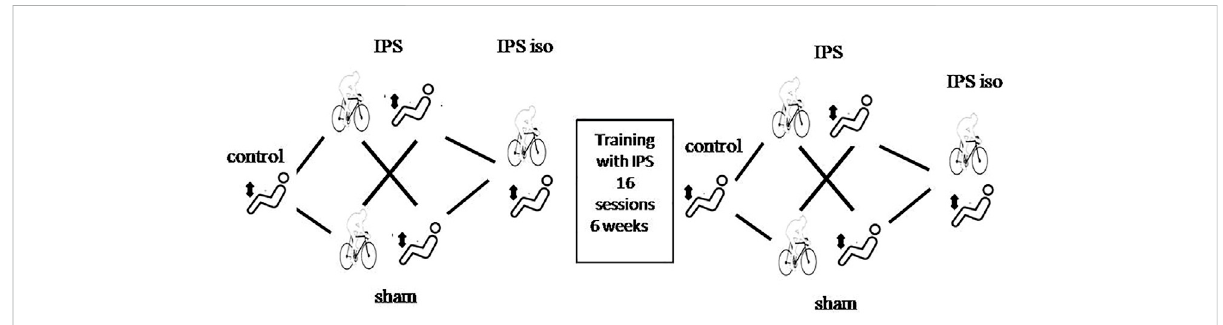
FIGURE 2 Study design. Quadriceps endurance (TlimQ) was assessed without (control) and after a constant workrate cycling exercise with effective ventilation (IPS) or sham ventilation in a random order. The tests were repeated similarly after completion of the pulmonary rehabilitation